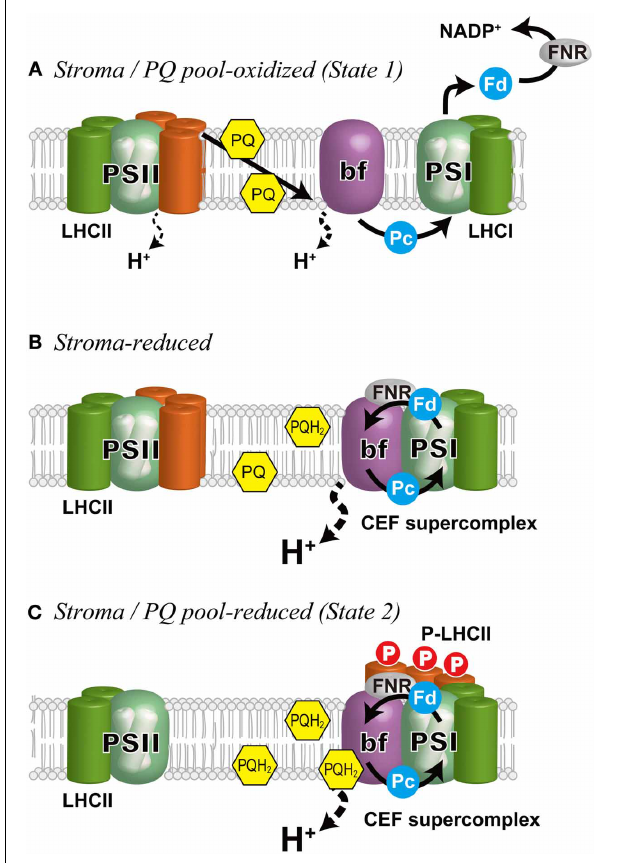
FIGURE 2 | Schematic representation of the regulation of state transitions and electron flow in C. reinhardtii . (A) Stroma/PQ pool-oxidized , when PSI is preferentially excited and the stroma and the PQ pool are oxidized. Under these conditions, LHCIIs are bound to PSII (State 1). The photosynthetic electron flow proceeds in LEF mode generating NADPH as well as a proton gradient across the thylakoid membrane that is used for ATP production. (B) Stroma-reduced , when the stroma is reduced, CEF is induced (Takahashi et al., 2013). The cytochrome b 6 f complex and ferredoxin NADP + reductase (FNR) are associated with PSI to form a super-supercomplex (CEF supercomplex). (C) Stroma/PQ pool-reduced , when the PQ pool is further reduced by the elevated CEF, migration of the mobile LHCIIs ( orange ) occurs on the PsaH side of PSI that is opposite the LHCI belt to establish State 2. bf, the cytochrome b 6 f complex; Fd, ferredoxin; Pc,